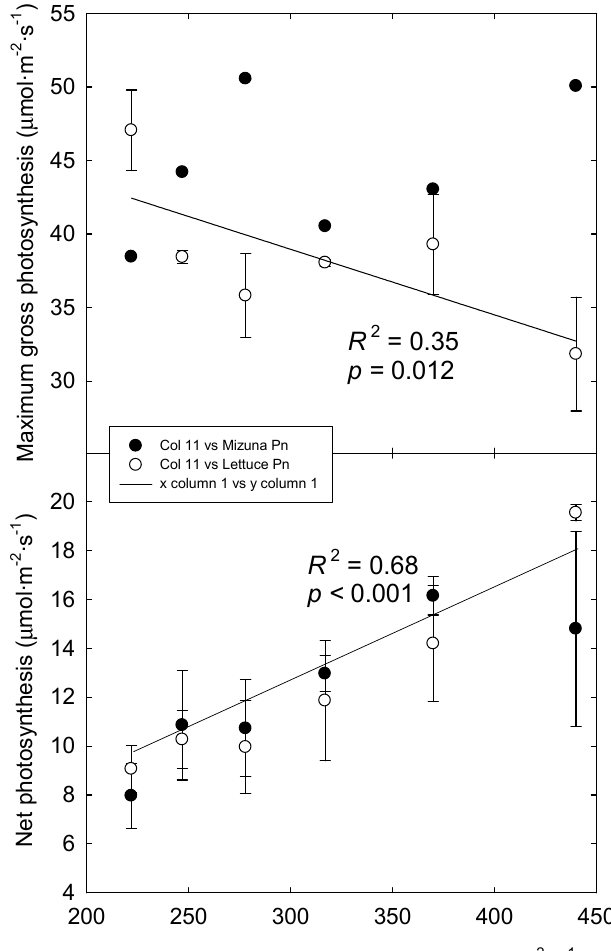
Figure 5. Light-saturated maximum gross photosynthesis (P g,max ) of lettuce and mizuna grown under varying photoperiods and photosynthetic photon flux densities (PPFDs) with the same daily light integral of 16 mol · m − 2 · d − 1 ( top ) and actual net photosynthesis at the PPFD the plants were grown at ( bottom ). Data were collected from the second experiment. Data points represent the mean ± SE ( n = 3). Lines indicates e ff ects of PPFD on the P g,max of lettuce ( top ) and the actual photosynthesis of lettuce and mizuna combined ( bottom ).